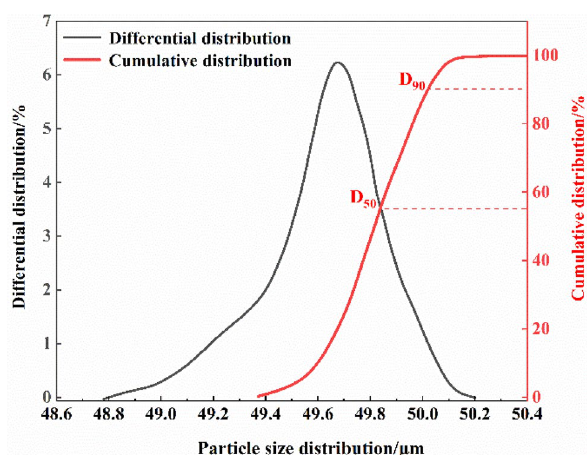
Figure 2. Particle size distribution.